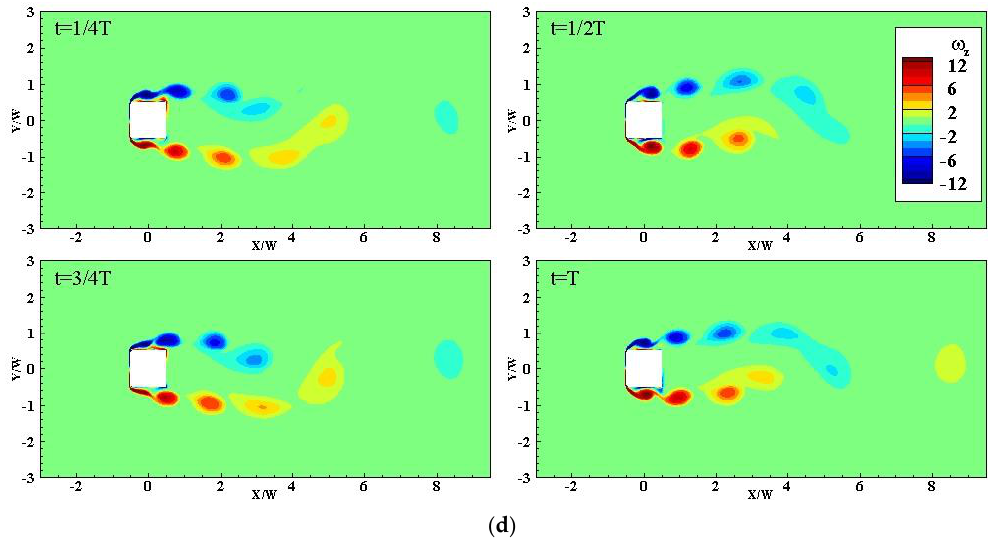
Figure 15. Normalized instantaneous vorticity distributions during one period: ( a ) plain cylinder; ( b ) S2 ; ( c ) R1 ; ( d ) R6 .